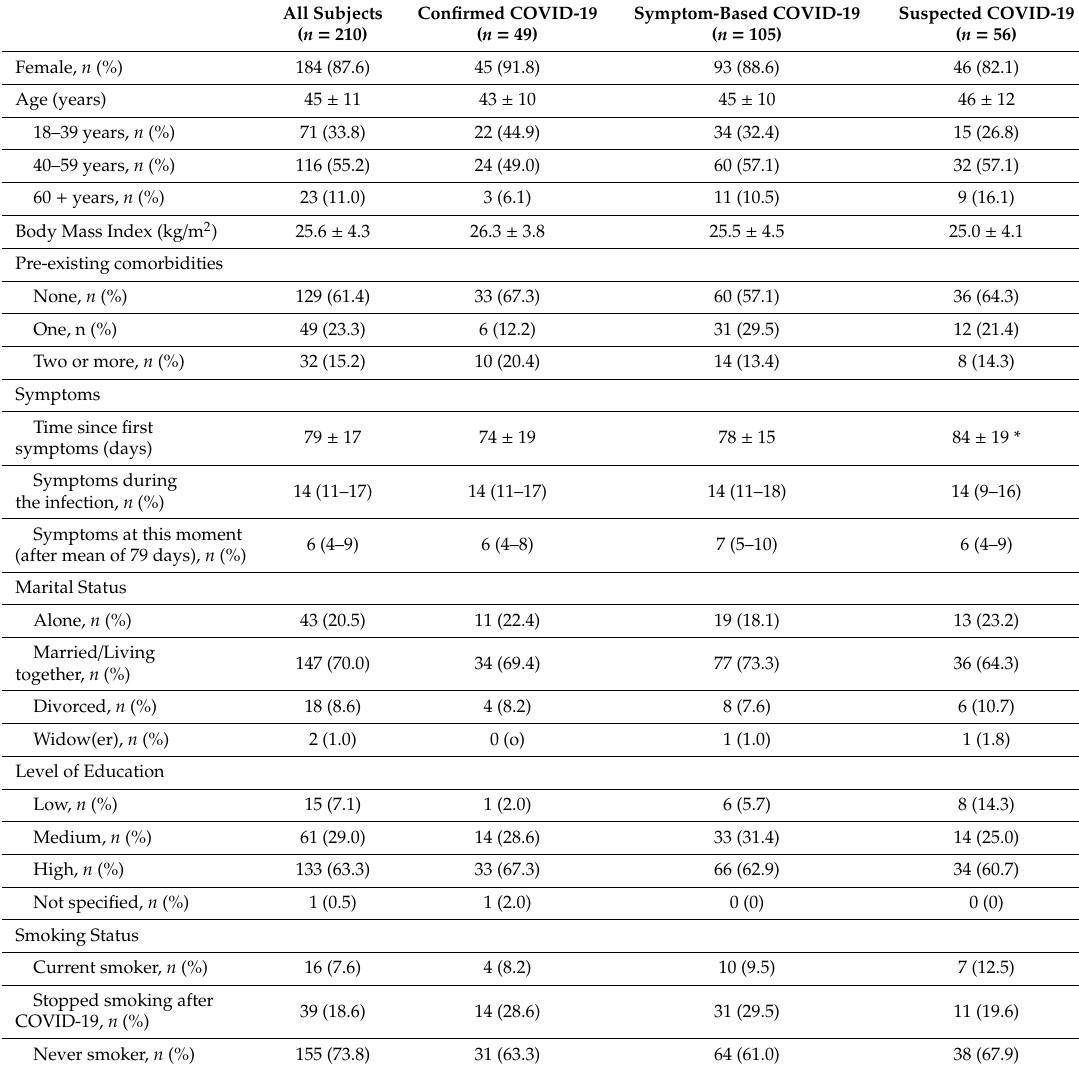
Table 1. General